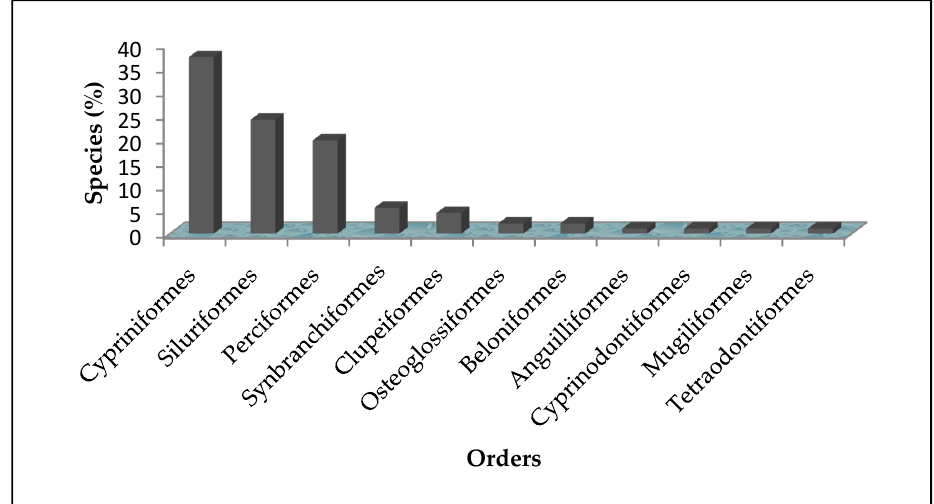
Figure 2. Fish species percentage by orders in the study area.